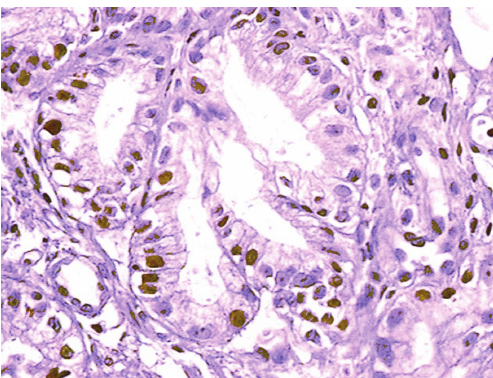
Figure 3: Example of immunohistochemical staining for Ki-67 antigen in Barrett’s esophagus under 200x microscopic magnifica- tion (stained cells are marked with an arrow).